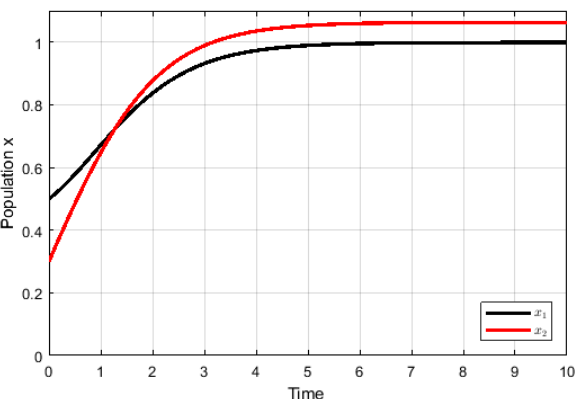
Figure 3. Evolution over time of the occupancy levels of two patches with different noise levels (more noise: black line; less noise: red line), when noise intensity is low. In this simulation, k = 3, i.e., the carrying capacity of the noisy patch ( K 1 ) is higher than that of the less noisy patch ( K 2